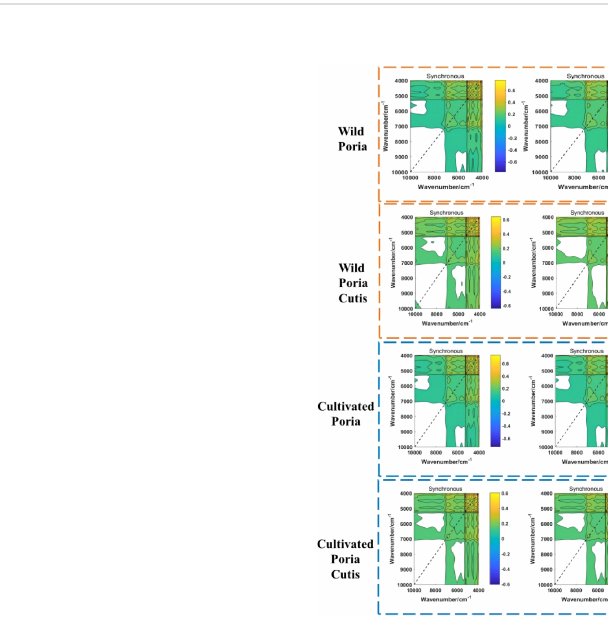
FIGURE 3 The synchronous 2DCOS images of wild and cultivated W. cocos in different parts.